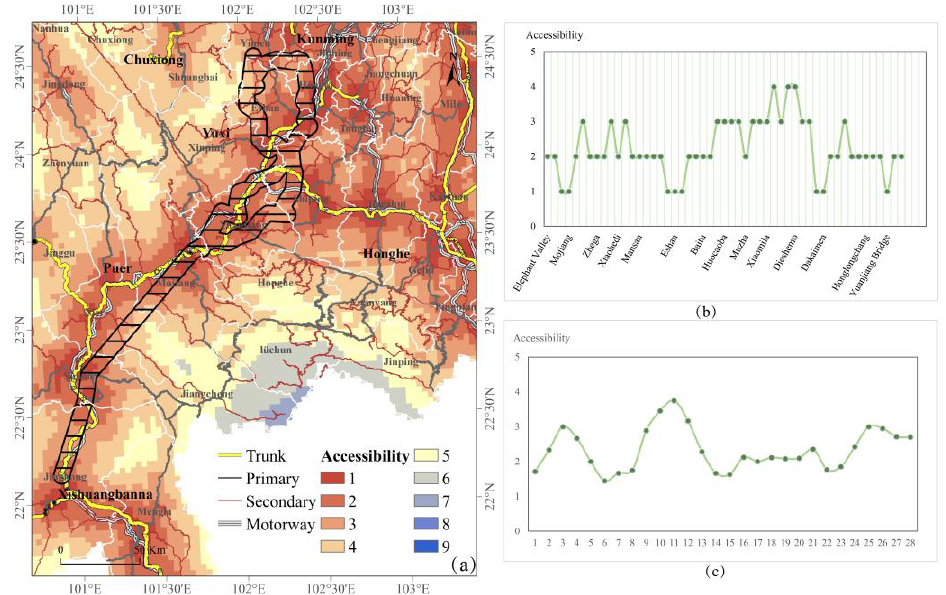
Figure 3. Traffic accessibility analysis of the movement route of Asian elephants. The figure was composed of three parts: ( a ) the spatial pattern of traffic accessibility, ( b ) the traffic accessibility change curve of recorded locations, and ( c ) the traffic accessibility change curve of the buffer grid from south to north.